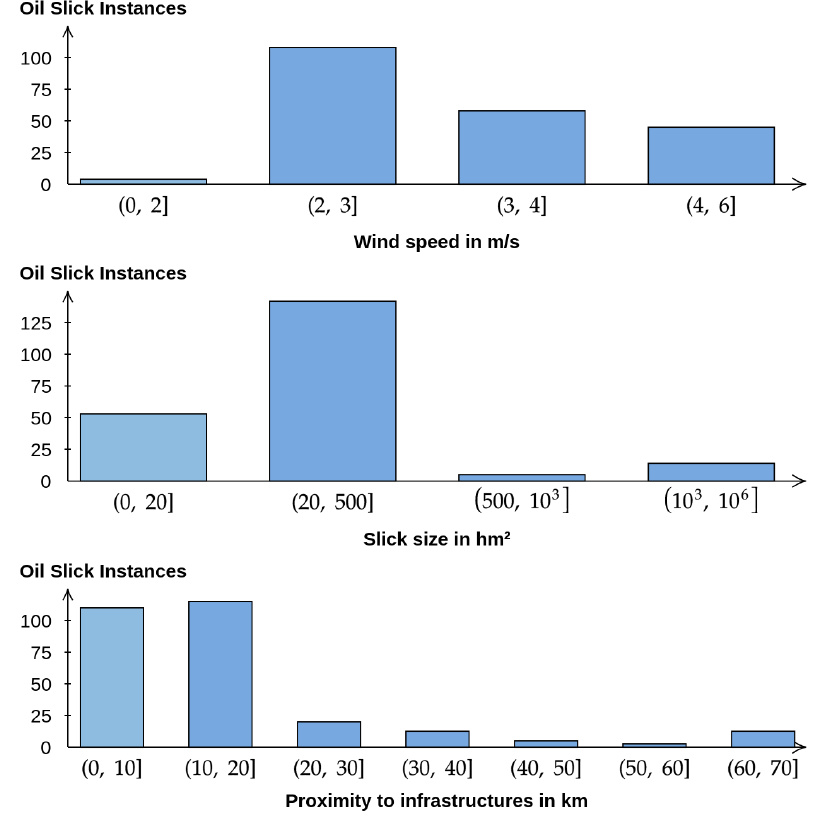
Figure 10. Distribution of slick instances in the test dataset as a function of (from top to bottom ) wind speed (m/s), slick size (hm²), and infrastructure proximity